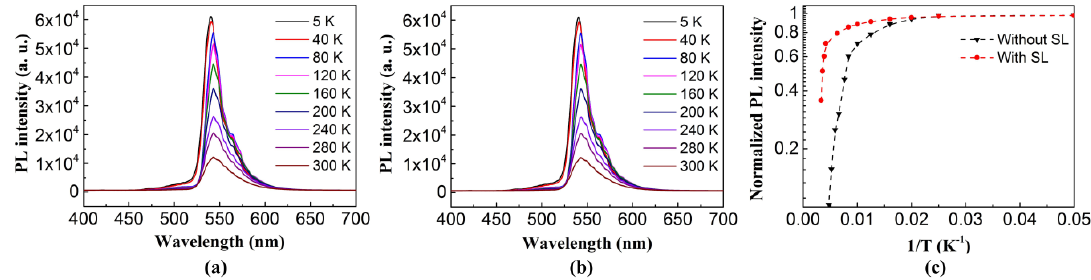
Figure 6. PL spectra of green LEDs ( a ) without and ( b ) with an InGaN/GaN SL; ( c ) Arrhenius plot of the normalized integrated PL intensity of the green MQWs without an SL and with an SL.